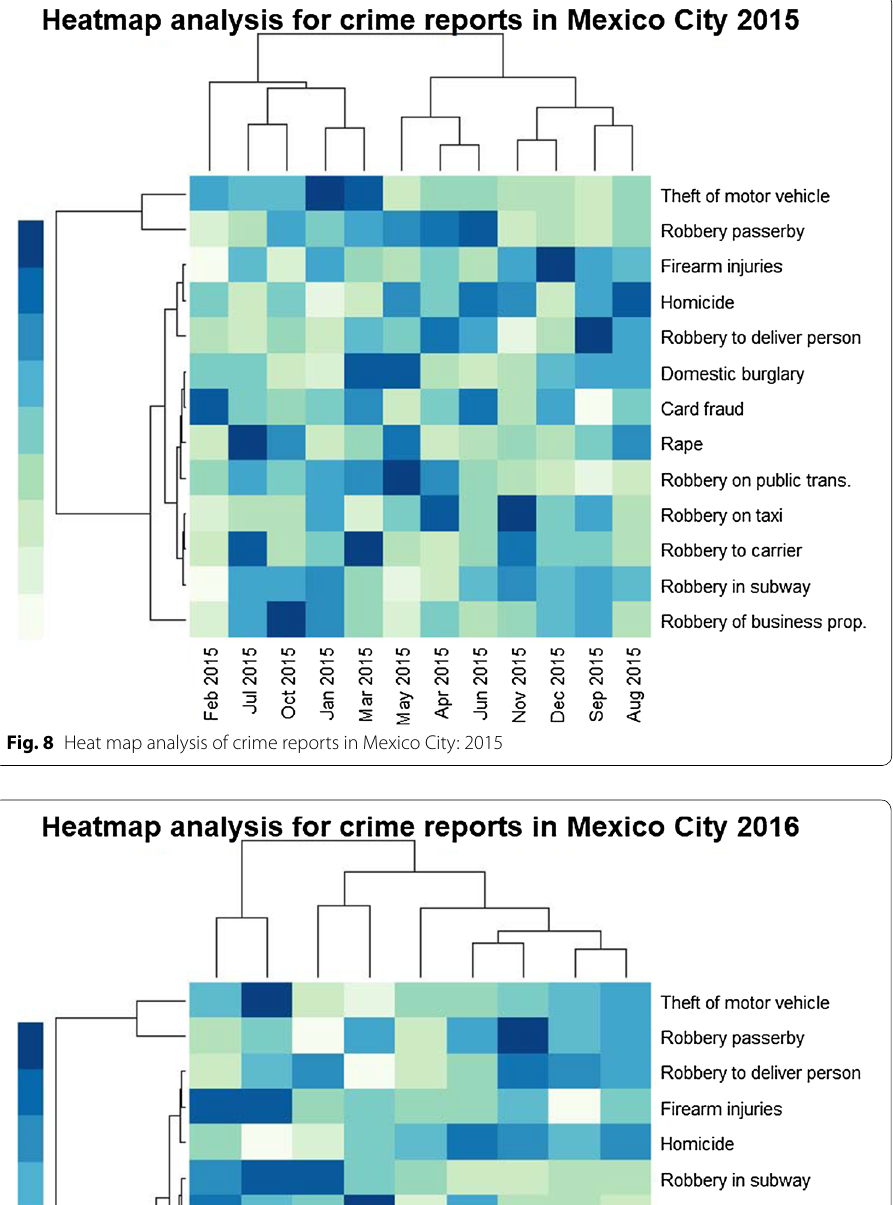
Fig. 9 Heat map analysis of crime reports in Mexico City: